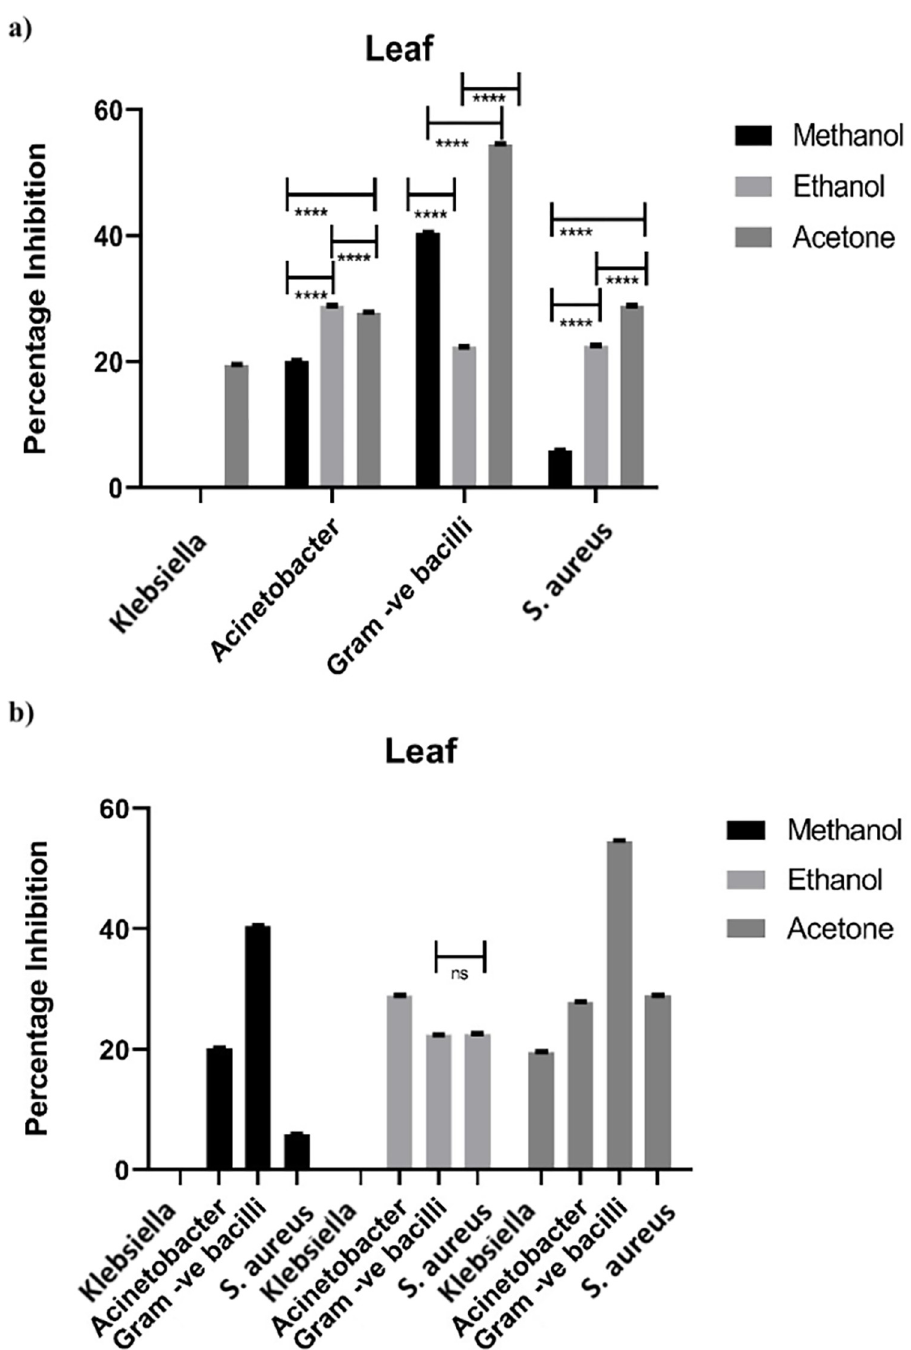
Fig 1. Statistical comparison of antimicrobial activity of leaf extracts against various bacteria. (a) Effect of all three solvents on an individual bacterium. (b) Comparison of each solvent with all selected bacterial spp. Bar represents ± SEM. Data was analyzed by two-way analysis of variance (ANOVA) (P < 0.001). * = significant; ns = non- significant.